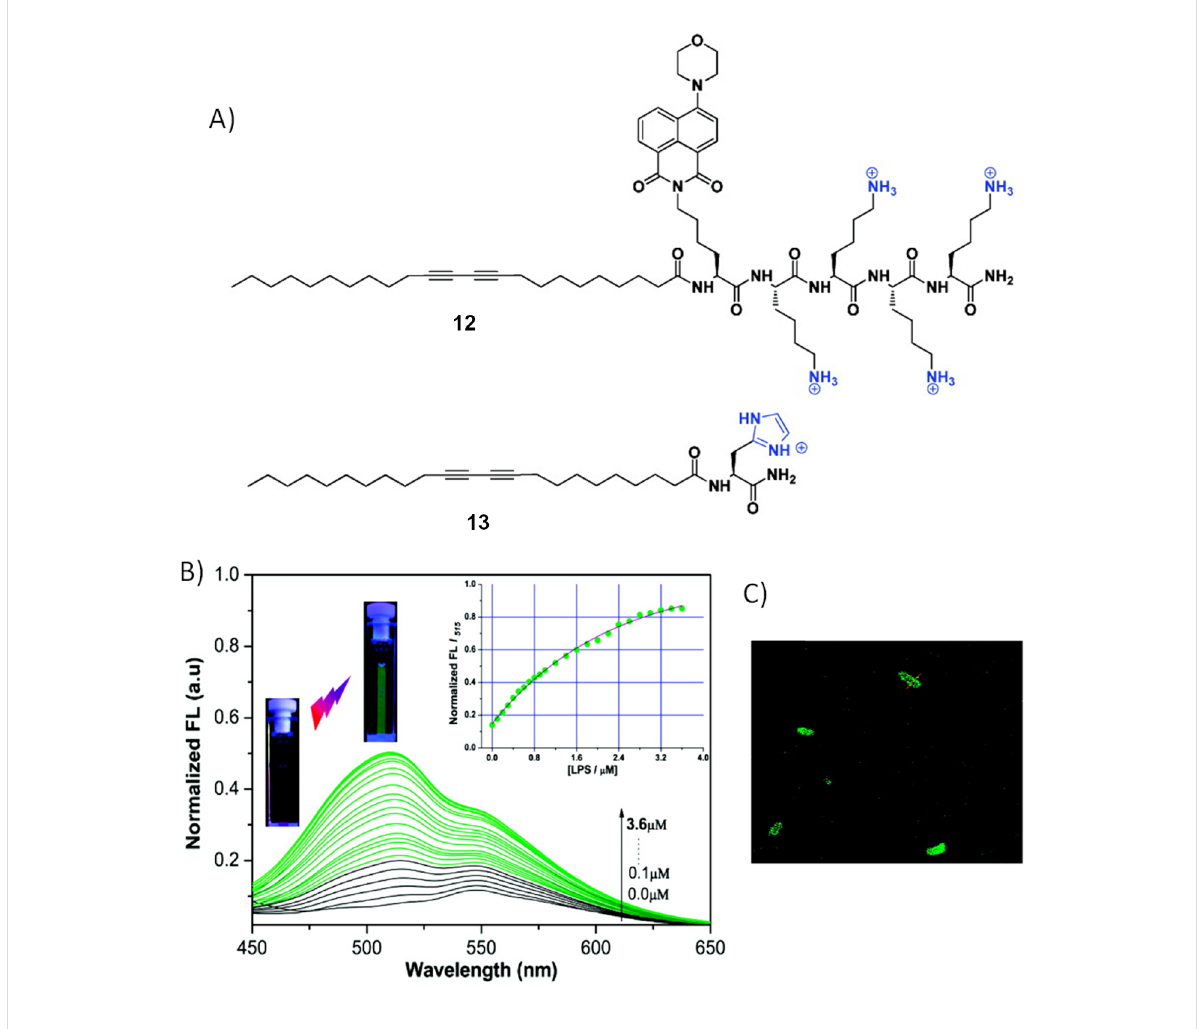
Figure 10: A) Structure of two peptide amphiphiles 12 and 13 ; B) fluorescent spectra ( λ ex = 400 nm) from a titration of the PDA liposomes (molar ratio 12 / 13 = 1:9, total monomer concentration = 10.0 μ M, 25 °C) in 10.0 mM DMSO/TBS (v/v = 1:4, pH 7.4). The insets show the normalized fluores- cence intensity at 515 nm vs the concentration of LPS (0–3.6 μ M) and the fluorescence turn-on; C) confocal luminescence image for E. coli DH5 α after incubation with the PDA liposomes. Reprinted with permission from [59]. Copyright (2011) American Chemical